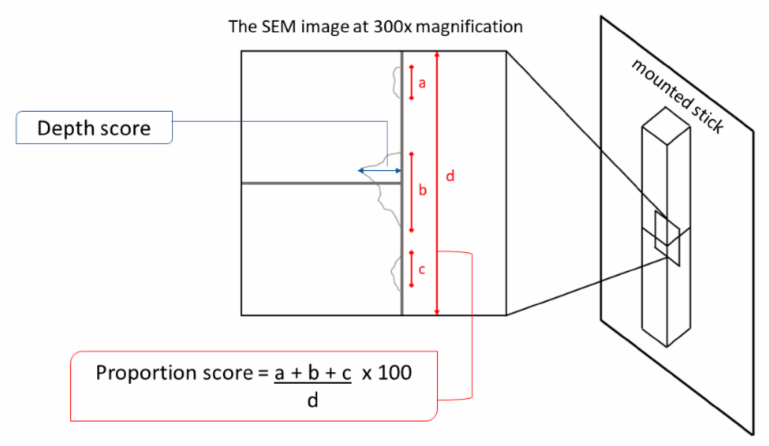
Figure 2. The measurement of the depth and proportion score of each external edge of the microspec- imen